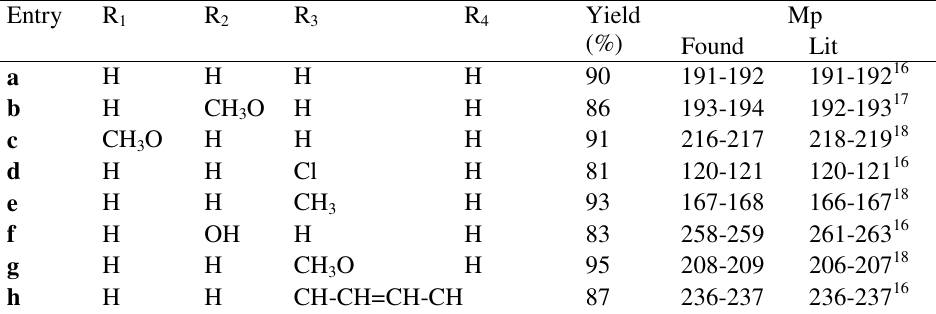
Table 2 . Synthesis of 3-carboxycoumarins in water under